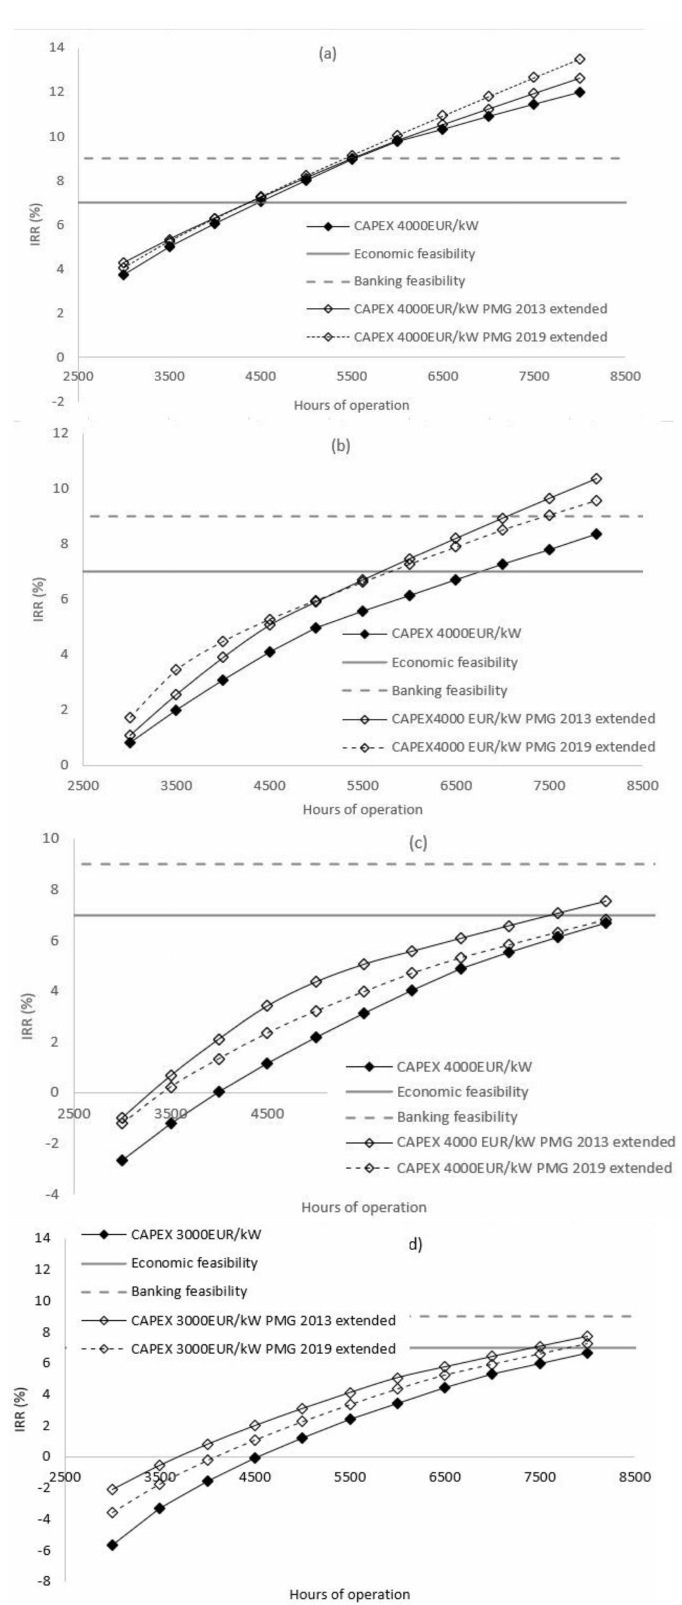
Figure 6. Internal rate of return vs. hours of operation comparing minimum guaranteed prices 2019 with minimum guaranteed prices 2013 extended to 2,000,000 kWh for capital expenditures 4000 EUR/kW for different plant sizes: 100 kW ( a ), 250 kW ( b ), 500 kW ( c ), and 1000 kW ( d